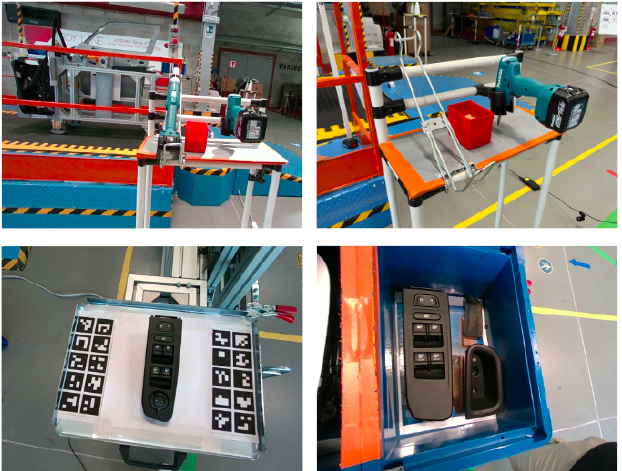
Figure 16. Sample training images from the real industrial environment dataset for the screwdriver ( top row) and the window control panel ( bottom